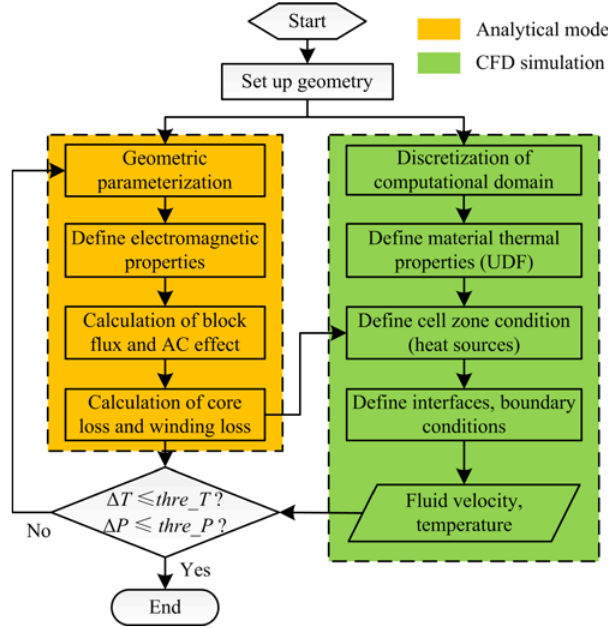
Figure 2. Overall framework of the coupled and semi-numerical